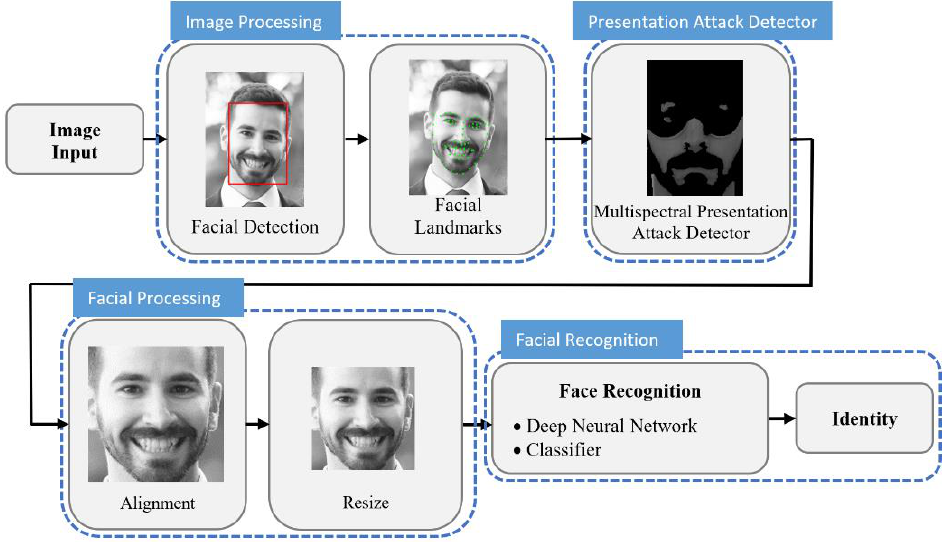
Figure 1. Block diagram of the proposed multispectral facial recognition